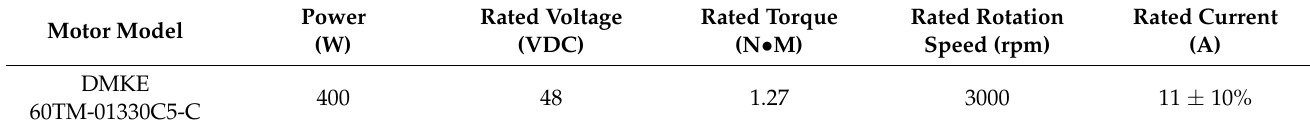
Table 4. Parameter table of matching reducer. Table 3. Parameter table of matching drive.